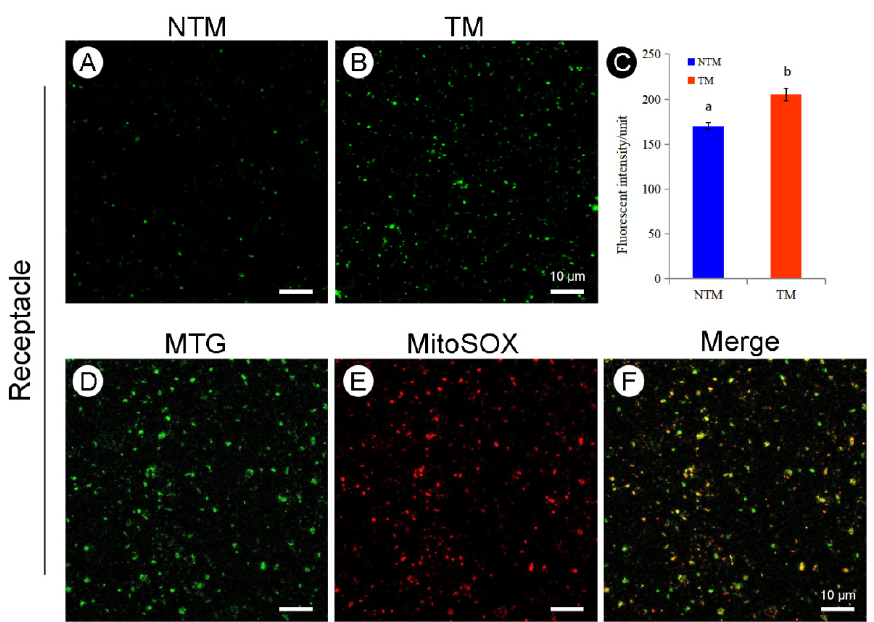
Figure 5. Reactive oxygen species (ROS) production and subcellular colocalization of ROS and mitochondria in the receptacle during the NTM and TM stages. ( A ) Mitochondrial ROS production in receptacle cells during the NTM (bud) stage. ( B ) Mitochondrial ROS production in receptacle cells during the TM (female) stage. ( C ) Comparison of the mean fluorescence intensity of mitochondrial ROS in receptacle cells during the NTM and TM stages. In ( C ), the different lowercase letters indicate a significant difference in fluorescence intensity of ROS between the floral stages according to the t -test. Data in the bars are the mean ± standard error, n = 10 flowers, 3 sections per sample, 6 view fields for observation in ( C ). p < 0.001. ( D ) Mitochondrial fluorescence intensity in the receptacle during the TM stage. ( E ) Fluorescence intensity of mitochondrial ROS in the receptacle cells during the TM stage. ( F ) Overlapping images from ( D , E ) show ROS accumulation in receptacle mitochondria during the TM and NTM stages. Scale bars, 10 µ